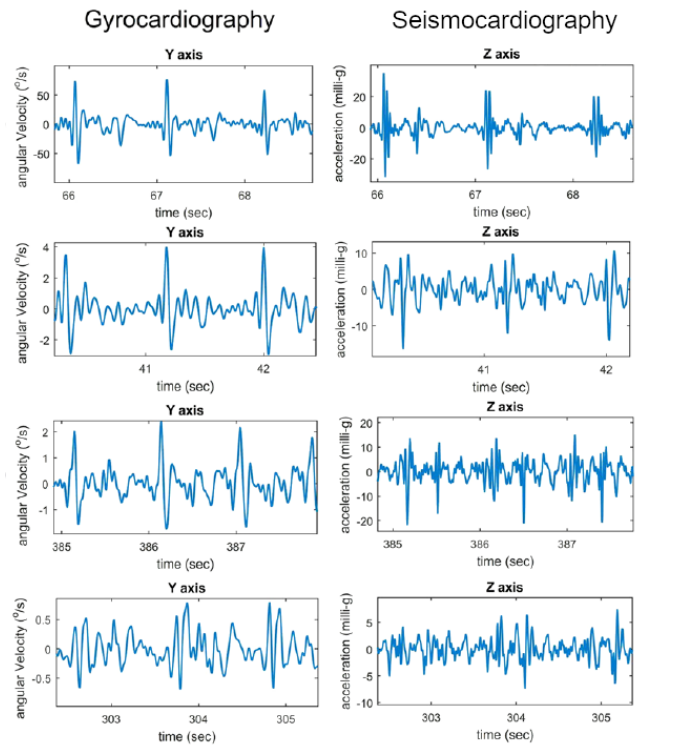
Figure 5. An example of GCG y-axis and SCG z-axis inter-subject variation with various levels of signal quality (top to bottom: good, medium, low and very low). Adapted version of the graph derived from the article [11] by Tadi et al. under the license CC-BY